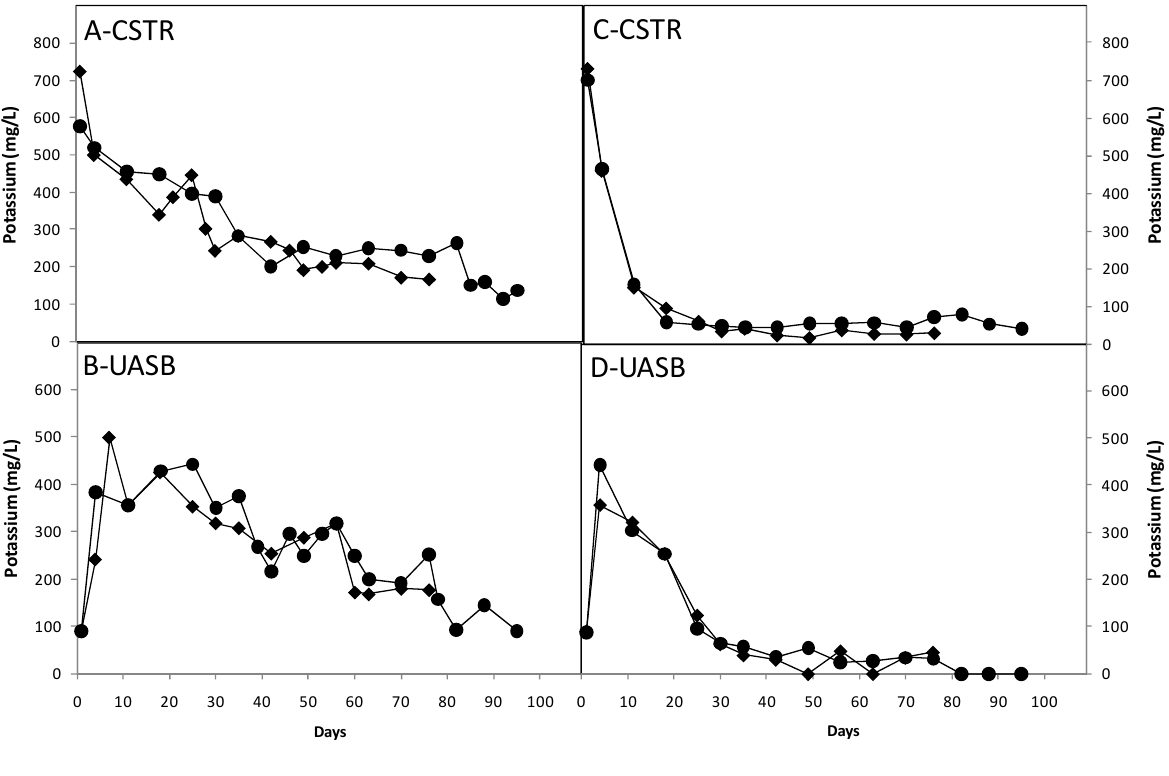
Figure 6. The potassium concentration during the experimental period. ● -